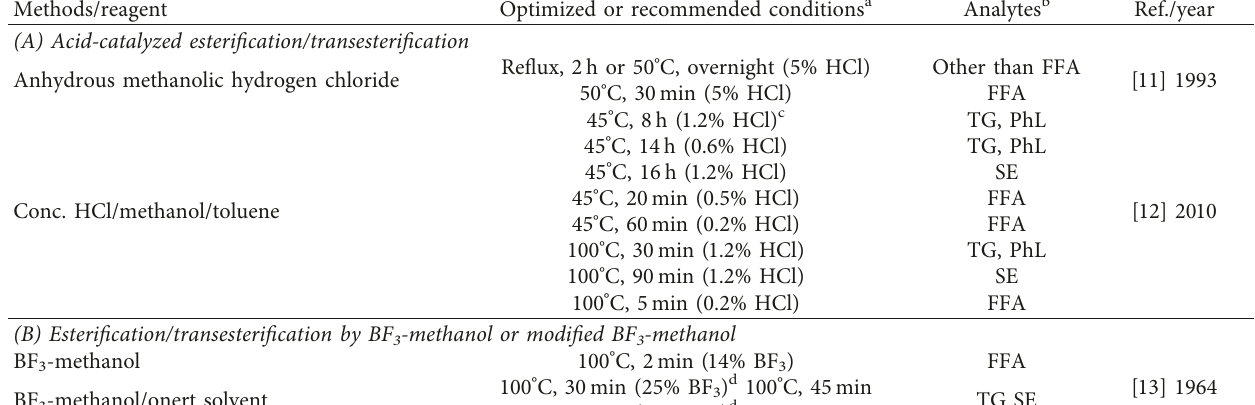
Table 1: Simplified comparison of typical preparation methods for fatty acid methyl esters from various